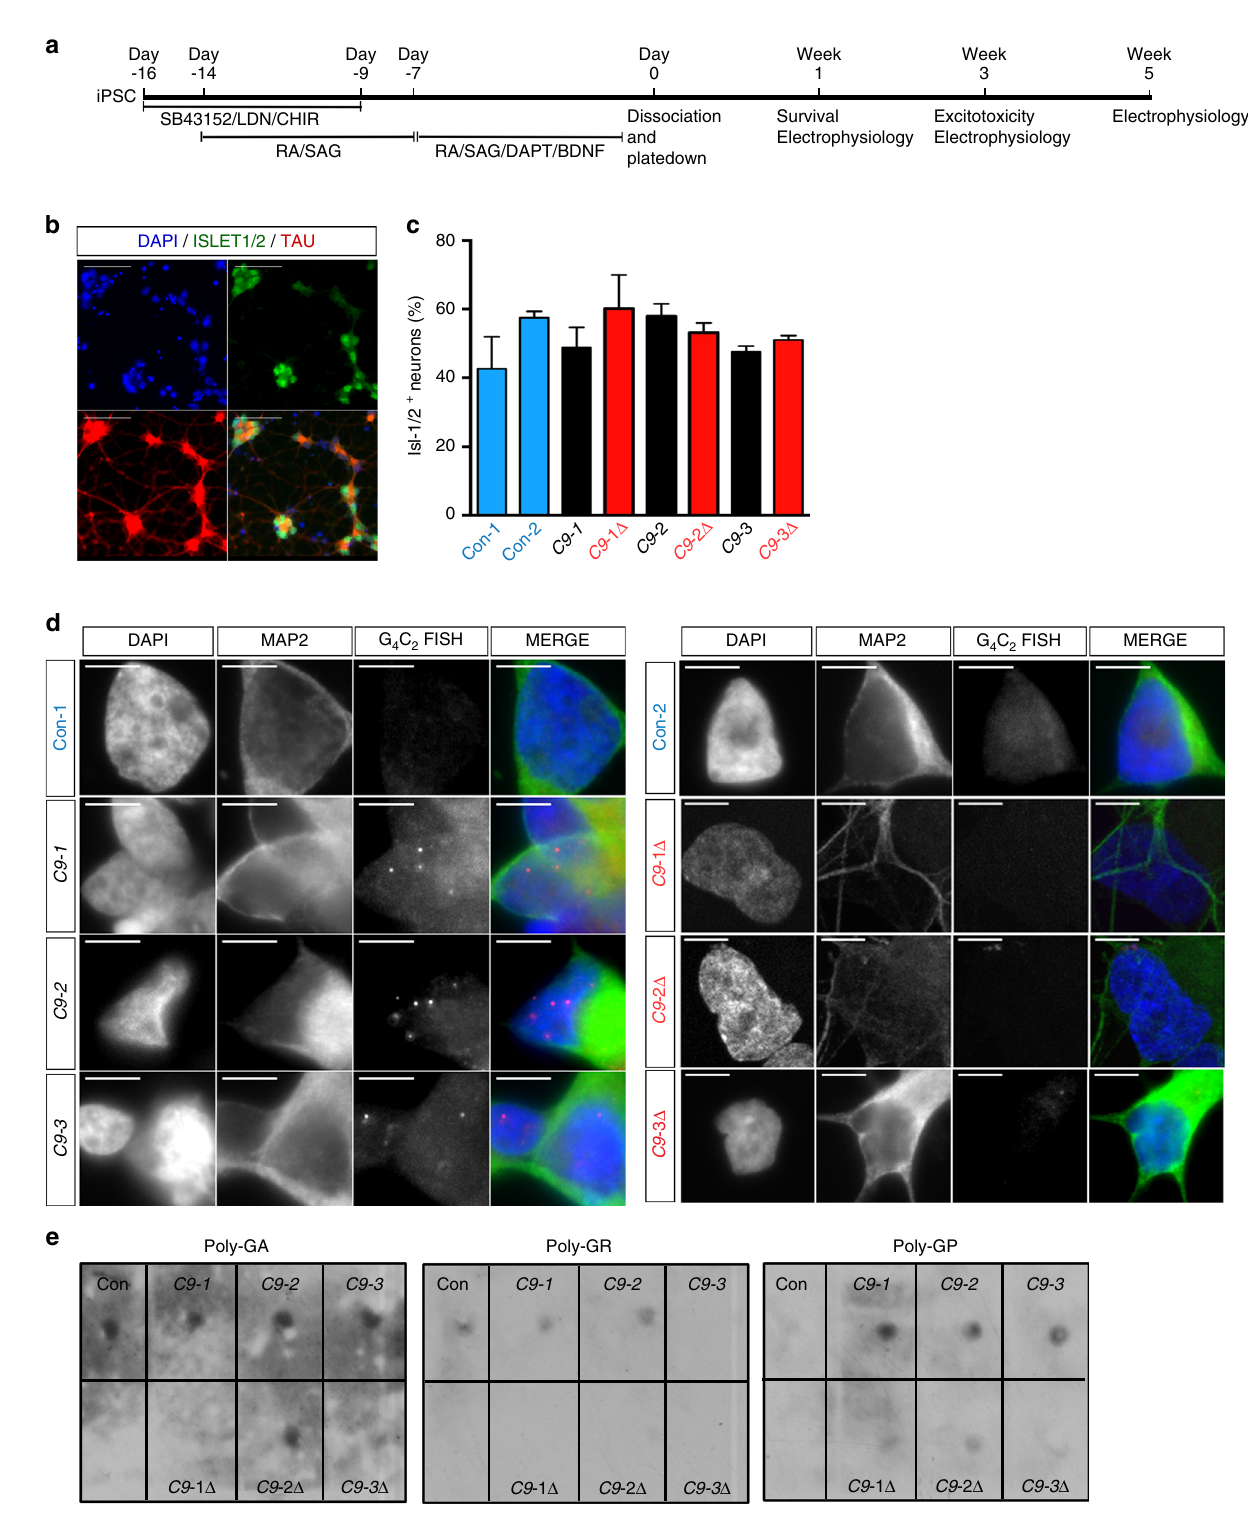
Fig. 2 Excision of the G 4 C 2 repeat expansion reverses RNA foci pathology in mutant MNs. a Schematic representation of MN generation and timings of various experiments performed. b Representative images of Isl1/2 and Tau immunostainings in 1-week-old MNs (scale bar: 50 µ m). c Percentage of Isl1/2 + MNs from various iPSC lines (data represented as mean ± s.e.m., Con-1, N = 3; Con-2, N = 3; C9-1, N = 3; C9-1 Δ , N = 3; C9-2, N = 3; C9-2 Δ , N = 2; C9-3, N = 3; C9-3 Δ , N = 3). d RNA fl uorescent in situ hybridization showed mutant C9ORF72 MNs exhibit intra-nuclear RNA foci (scale bar: 5 µ m). e Representative dot-blots for poly-GA, poly-GP, and poly-GR DPRs in mutant C9ORF72 MNs. RA retinoic acid, SAG smoothened agonist, DAPT N-[N-(3,5-Di fl uorophenacetyl)-L-alanyl]-S-phenylglycine t-butyl ester, BDNF Brain-derived neurotrophic